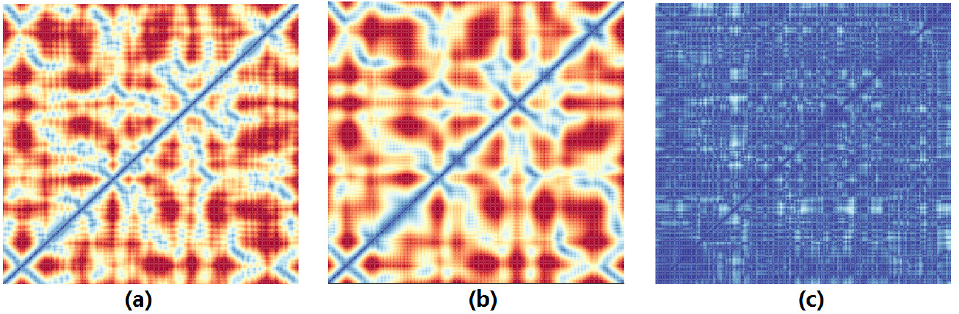
Figure 3. Visualization of the distance matrix. The horizontal and vertical axis is the length of the certain protein chain, and each point represents the distance between the i th residue and the j th residue (the progressive color from blue to red indicates that the distance is getting farther). The dRMSD of this protein chain is obtained from the Matrix Heatmap. The more complex the chart, the larger the dRMSD . ( a , b ) shows the distance matrix heat map of the predicted structure and the real structure. ( c ) shows the distance matrix heat map of the corresponding position difference in the distance matrix of the predicted structure and the real